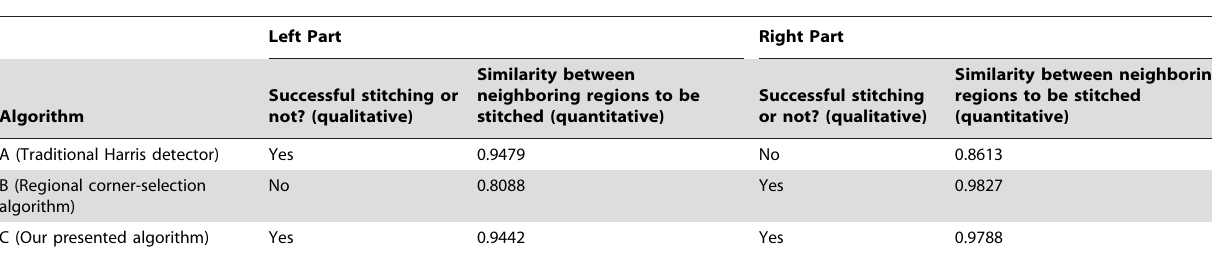
Table 4. Qualitative and quantitative analysis on three different algorithms (I).